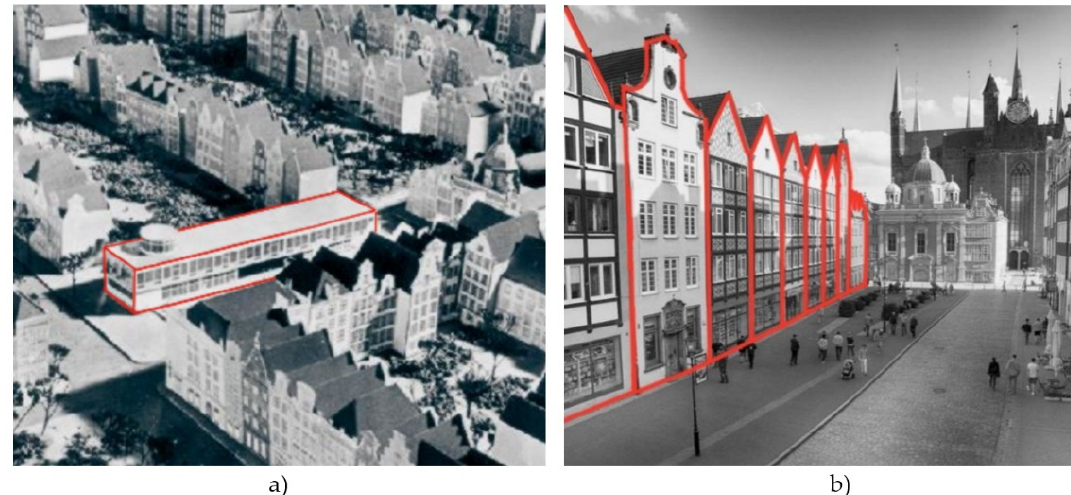
Figure 8. Eastern frontage of Grobla I Street in Gda ń sk: ( a ) modernist design from 1957 [51], ( b ) realisation in the form of tenement houses 1958. Source: compiled by A. Taraszkiewicz.